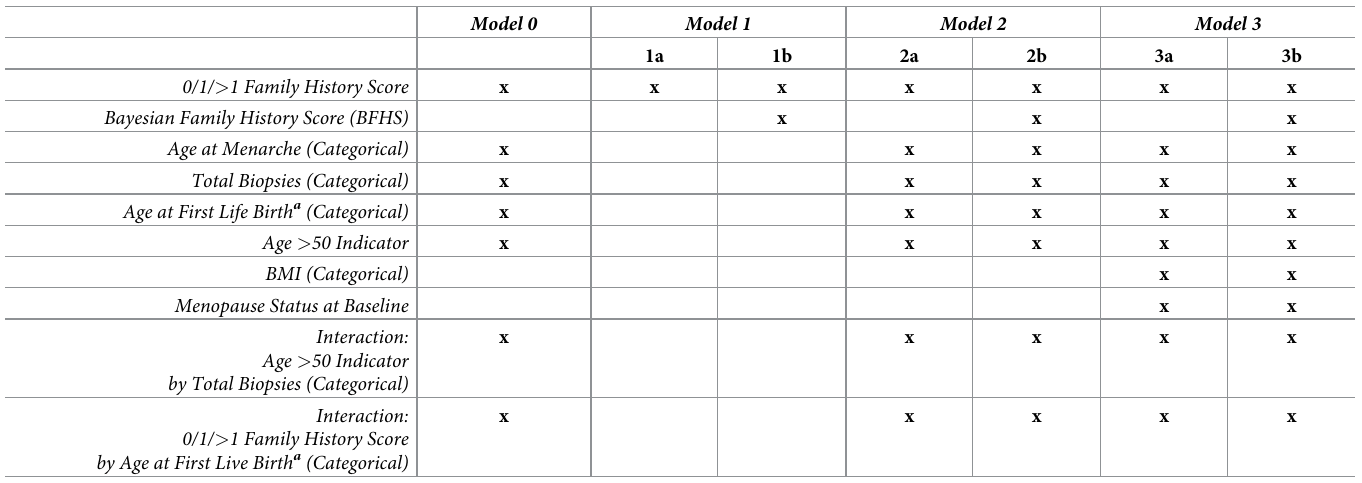
Table 1. Models to be